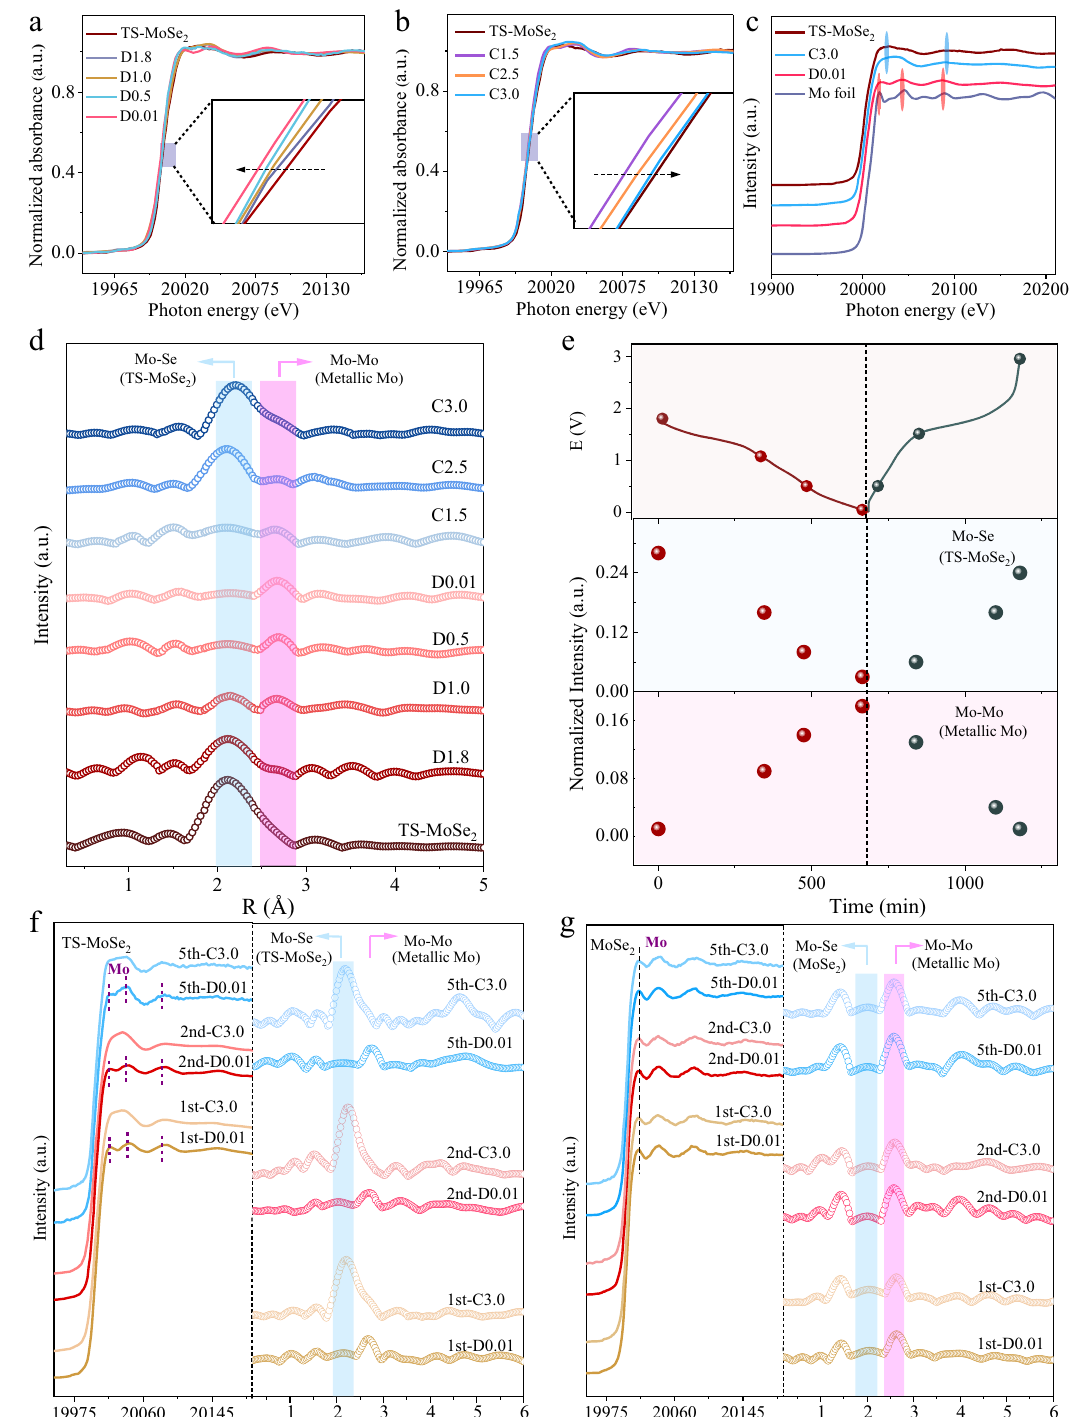
Fig. 4 | Study on discharging and charging processes based on ex situ XAS. Ex situ Mo K-edge XANES spectra of TS-MoSe 2 during the fi rst a discharged and b charged states. c Mo K-edge XANES spectra of pristine TS-MoSe 2, fully dis- charged TS-MoSe 2 (D0.01), fully charged TS-MoSe 2 (C3.0), and Mo foil. d Evolution of Mo K-edge EXAFS during electrochemical cycling. e The